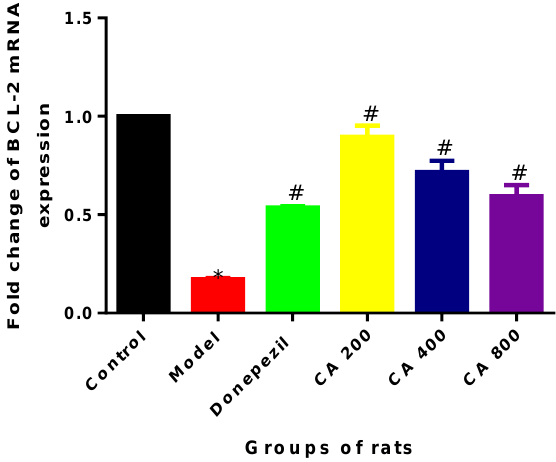
Figure 2. Effects of CA on mRNA expression of Bcl-2 in the hippocampus of rats. Donepezil and CA effectively increased Bcl-2 mRNA expressions. Values are expressed as mean ± SD ( n = 3). * p < 0.05 vs. Control, # p < 0.05 vs. Model group of rats.